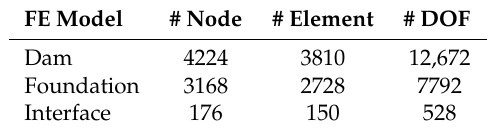
Table 5. Features of the dam and foundation FE model